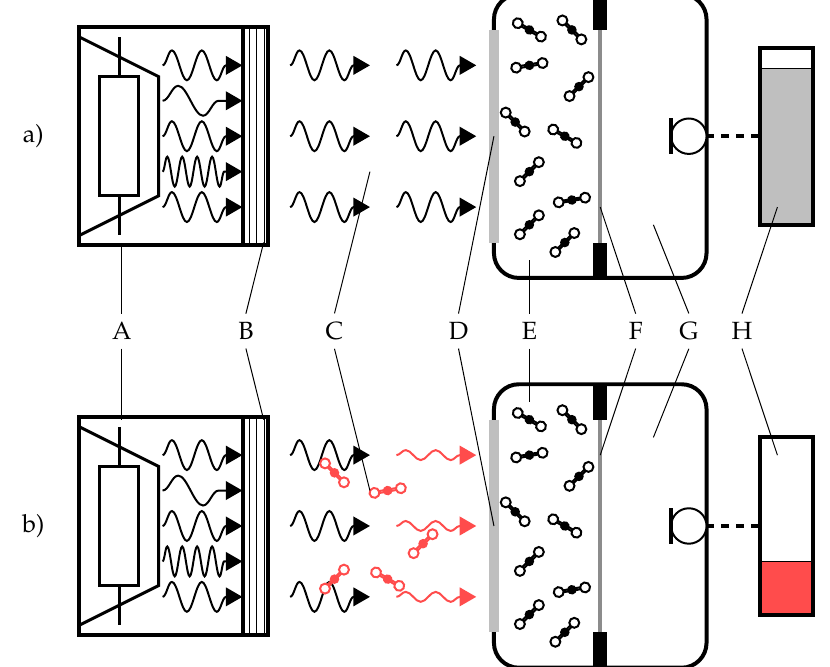
Figure 1. Conceptual sketch of the proposed sensing mechanism comprising: (A) pulsed IR-emitter (B) optical filter (optional) (C) optical absorption path (D) IR-transparent entrance window (E) her- metic cell with encapsulated CO 2 (F) flexible membrane (G) acoustically tight cavity with microphone (H) sensor signal. ( a ) sensor without CO 2 ( b ) sensor in presence of CO 2